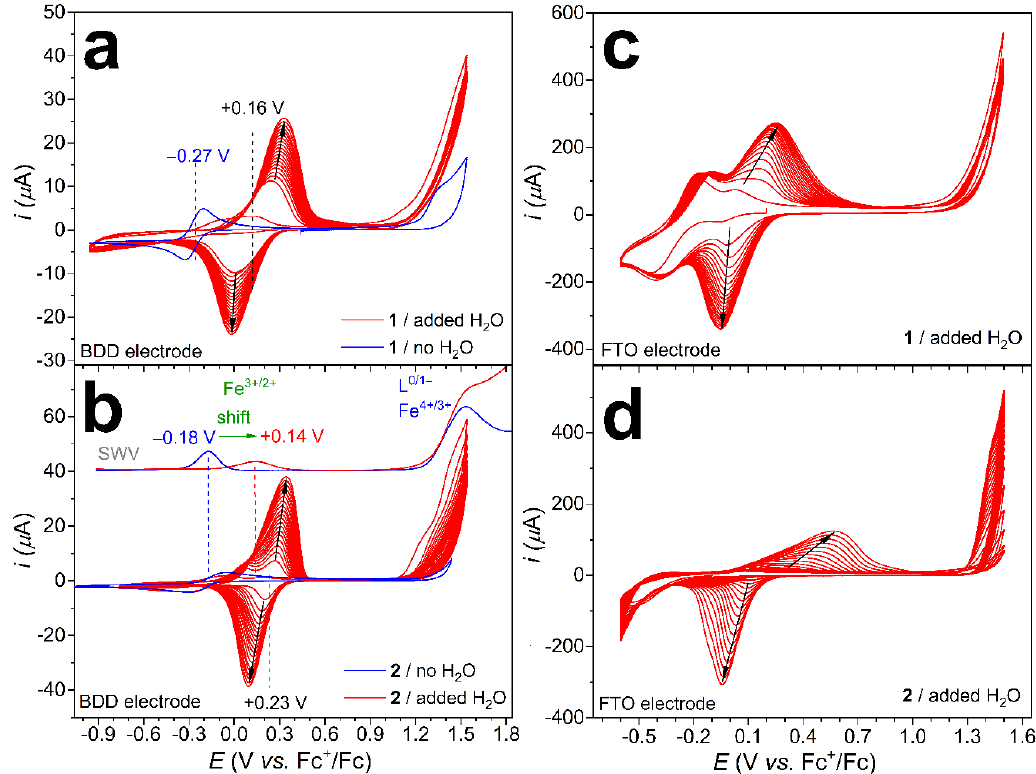
Figure 3. ( a ) CV scans of 1 (0.4 mM) in dry DCM (in blue) or with added H 2 O (in red, 3 mmol H 2 O in 0.5 mL acetone) on a BDD electrode (0.071 cm 2 ) ; ( b ) CV scans of 2 (0.4 mM) under the same conditions as those in ( a ), inset: SWV showing the potentials of the redox transitions in the two different media; ( c ) CV scans of complex 1 (0.8 mM) on FTO (1.5 cm 2 ) in DCM with added water (3 mmol of H 2 O in 0.5 mL acetone, see also the ED method); ( d ) CV scans of complex 2 (0.8 mM) under the same conditions as those in ( c ). Settings: under Ar, ν = 100 mV/s, 20 cycles (red CVs), Pt and Ag + /Ag (0.01 M AgNO 3 , 0.1 M TBAP/acetonitrile), as counter and reference electrodes,